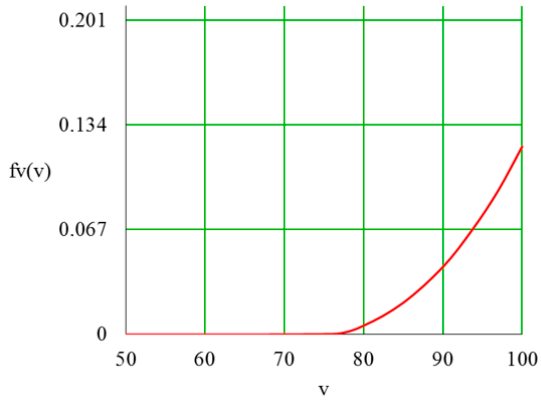
Figure 3. The probability density plot—Q4.